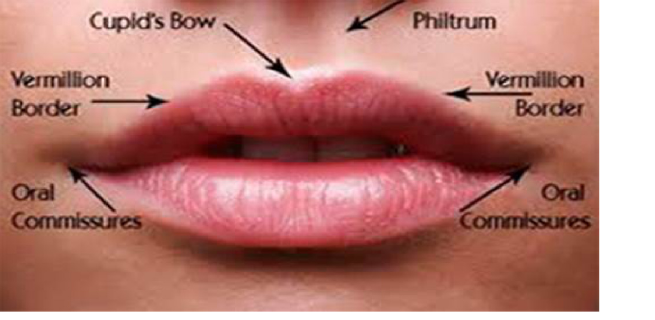
Fig 1. Basic morphological lip